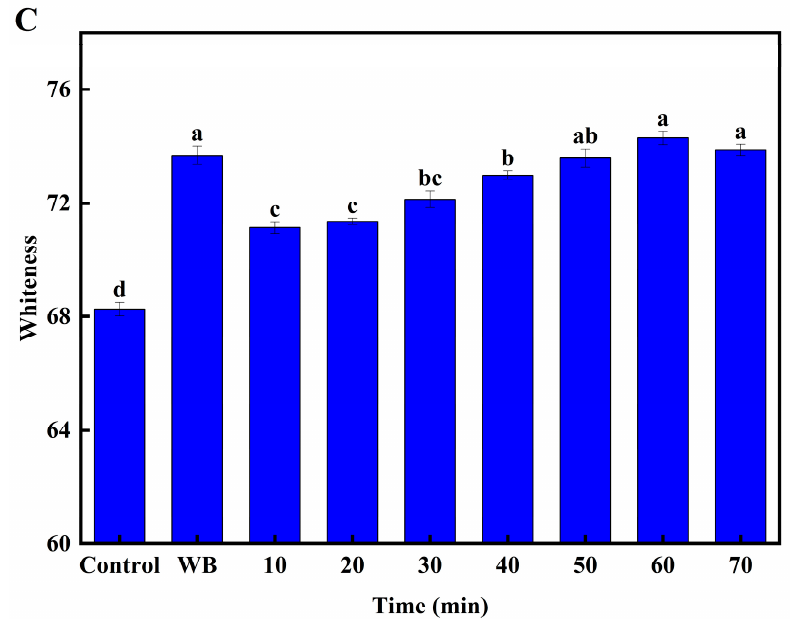
Figure 2. Effect of different DPCD treatments on surimi whiteness ( A ): Pressure, ( B ): Temperature, ( C ): Time. Different letters indicate statistically significant differences ( p < 0.05).